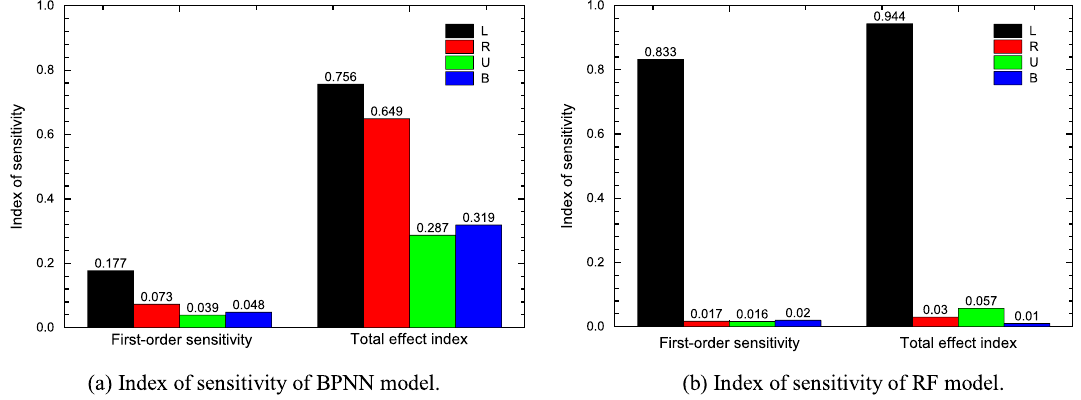
Figure 19. Comparison of sensitivity index between BPNN model and RF